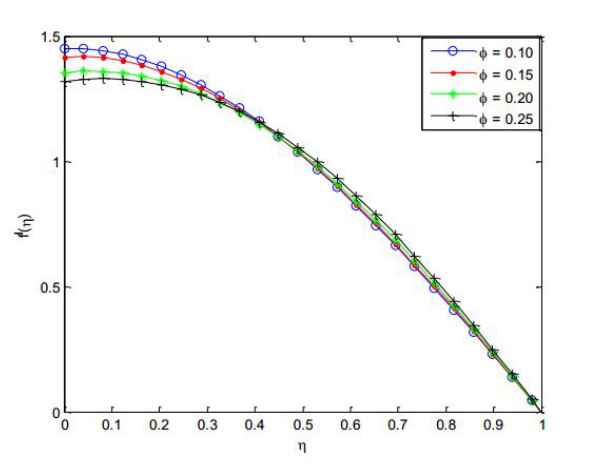
Figure 7. Effects of nanoparticle fraction on the velocity